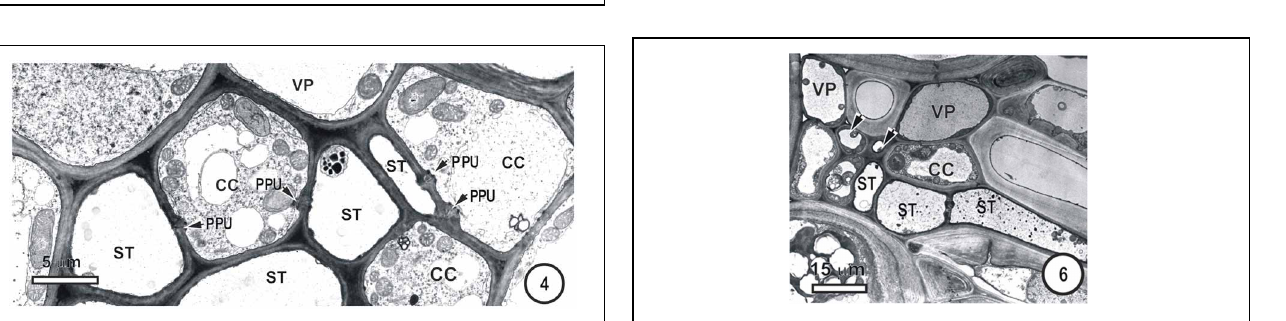
FIGURE 3 | Detail from a small-intermediate bundle in the rice leaf blade. Pore-plasmodesma units (paired arrowheads, left) connect TST at left, to the VP cell above. The ST (upper right) is connected via PPUs to a companion cell (CC) via PPU (paired arrowheads, upper right) and the two ST (right) are connected via a lateral sieve area (LS). Plasmodesmata (Pd, left) interface VP cells. No connections between thick-and thin-walled sieve tubes are visible in this TEM image.